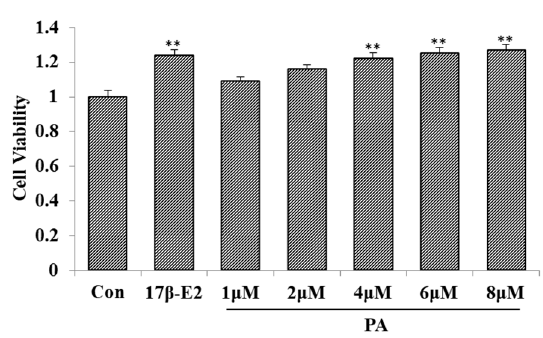
Figure 4. Effect of 2-phenylacetamide (PA) on MCF-7 cell proliferation ( x ± SD, n = 3). ** p < 0.01 compared to control using a Student’s t -test.